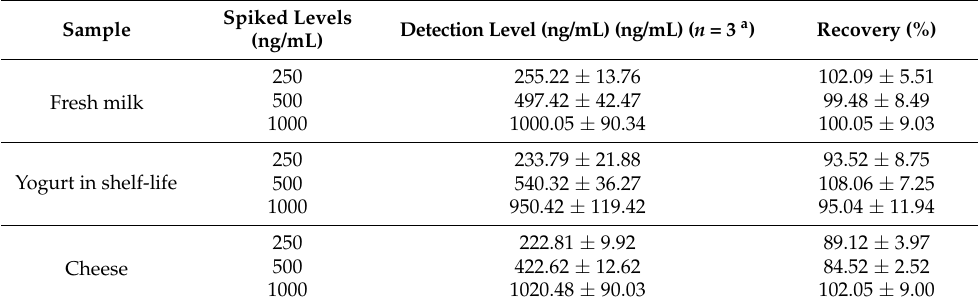
Table 2. SEC recovery in spiked dairy products via sandwich